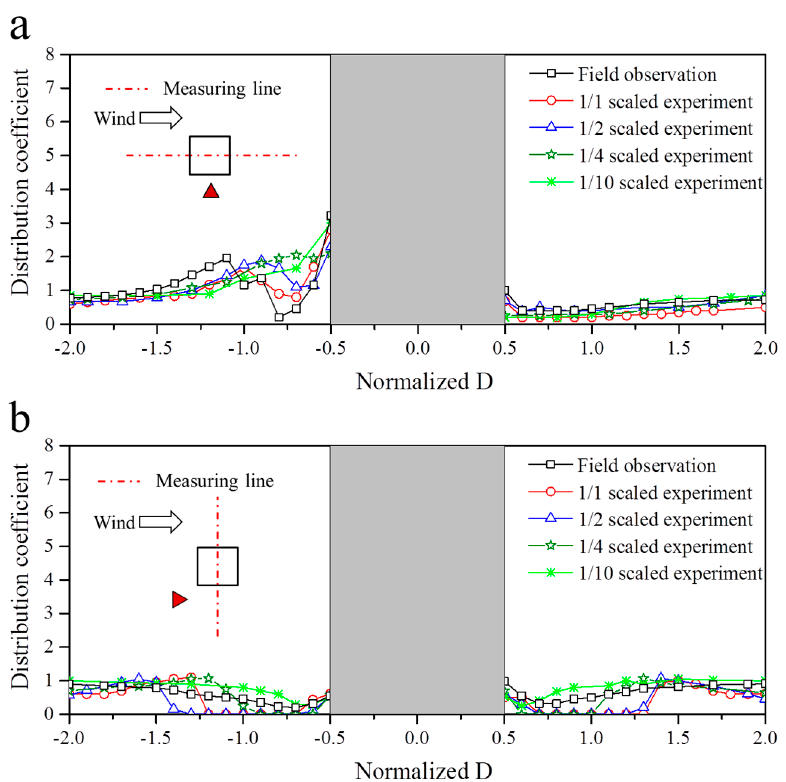
Figure 14. Comparison between normalized snow depths obtained from field observations and scale experiments: ( a ) streamwise direction (center section) and ( b ) lateral direction (center section).